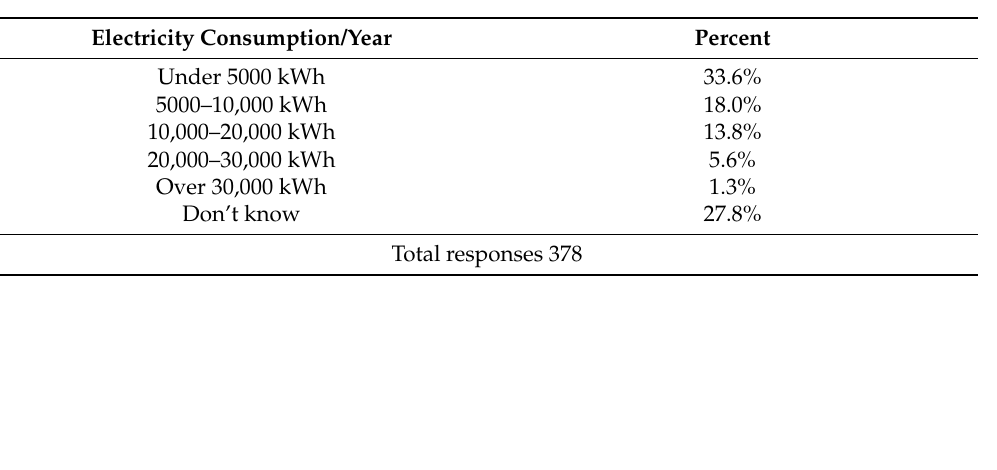
Table A1. The amount of electricity consumption by the